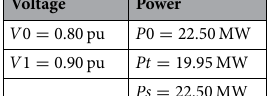
Table 16. Voltage and power values in the selected points of the